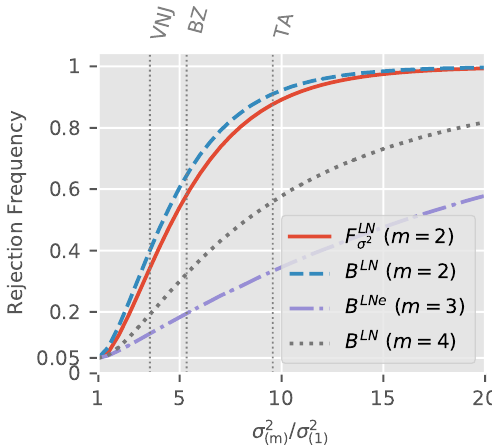
Figure 6. Power curves for log-normal dispersion tests based on sub-sample structures from empirical applications. Empirical maximum to minimum ratios indicated by horizontal lines. BZ is short for Barnett and Zehnwirth (2000), VNJ for Verrall et al. (2010), and TA for Taylor and Ashe